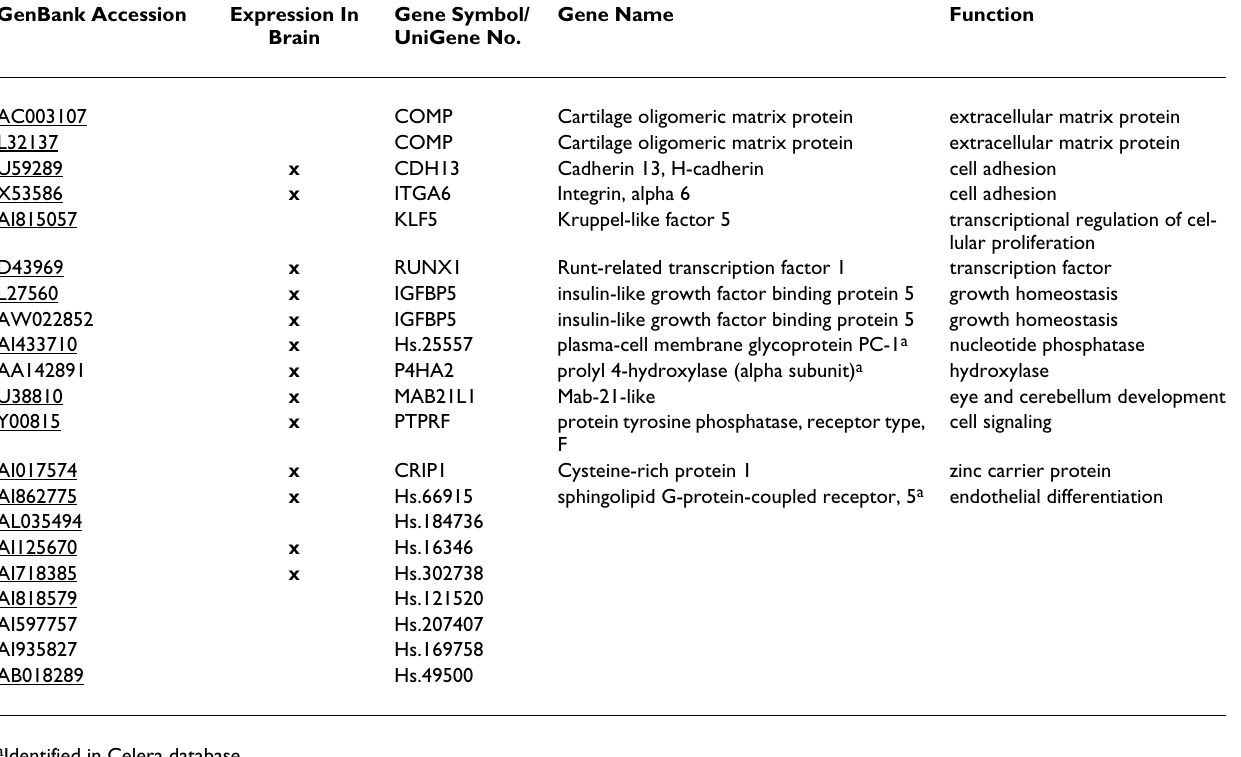
Table 2: Genes with decreased levels of expression in at least 3 of 4 mutant MeCP2 expressing clonal fibroblast cell strains when com- pared to matched clonal wild type MeCP2 expressing cell strains GenBank Accession Expression In Gene Symbol/ Brain UniGene No.